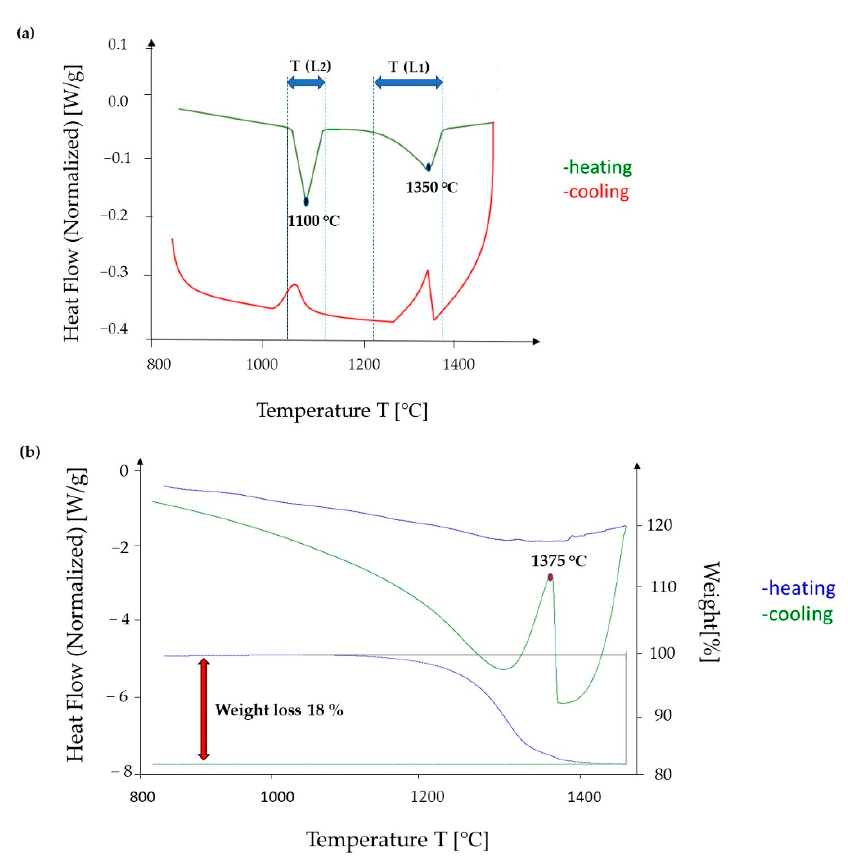
Figure 5. Differential scanning calorimetry curves for casted CCNA at a heating and cooling rate of ( a ) 20 °C min, the green curve indicates heating, while the red indicates cooling ( b ) 0.5 °C min, the blue curve indicates heating, while the green indicates cooling.